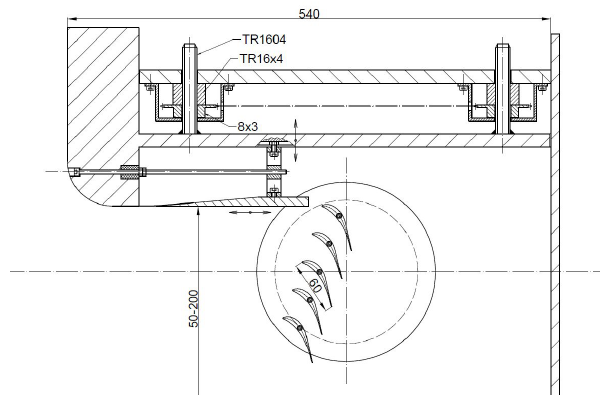
Fig. 2. The scheme of the test section and the controlled adjustable walls.